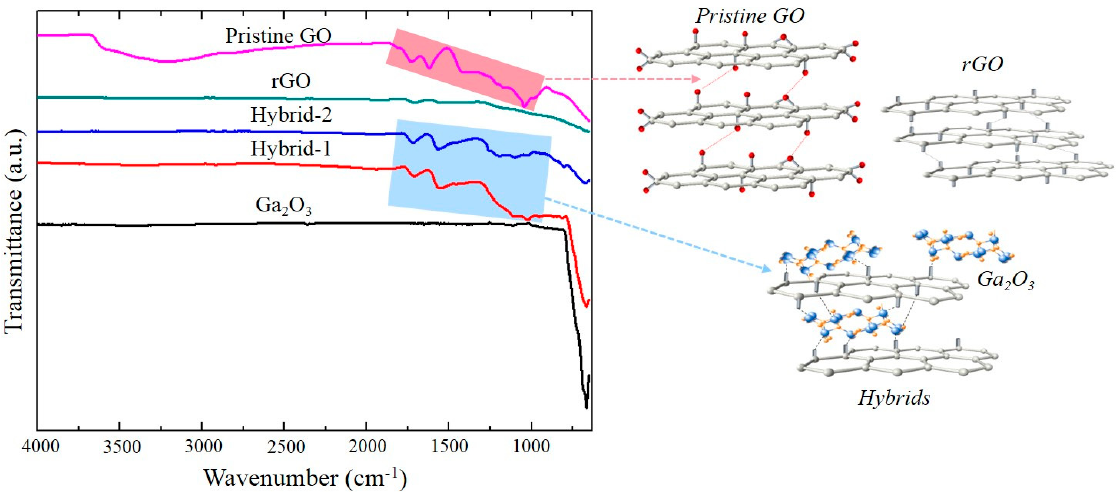
Figure 2. FTIR spectra of pristine GO, rGO, Hybrid-2, Hybrid-1 and Ga 2 O 3 , along with schematic chemical structure of GO, rGO and Ga 2 O 3 -rGO hybrids.